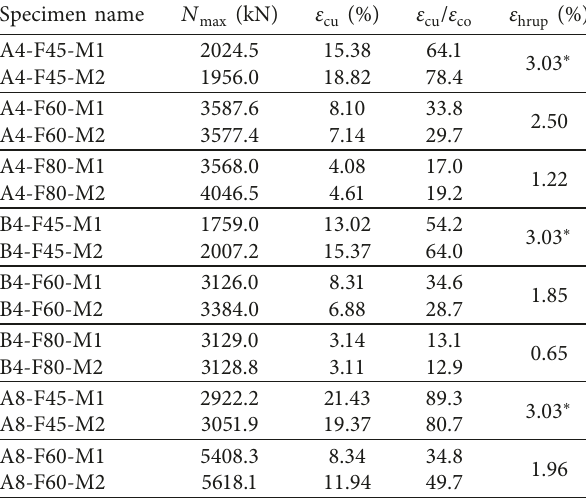
Table 5: Key test